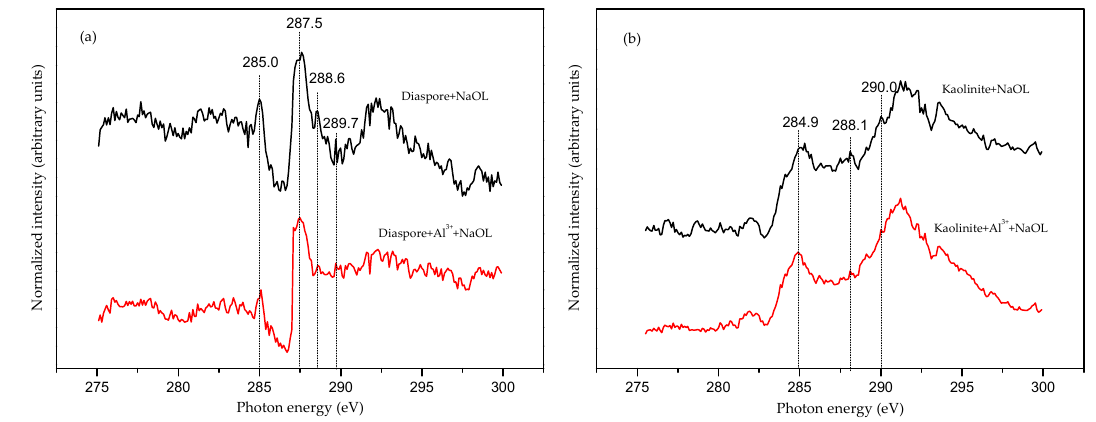
Figure 8. C 1s Near Edge X-ray Absorption Fine Structure (NEXAFS) total electron yield spectra of: ( a ) diaspore and ( b ) kaolinite (pH = 9).